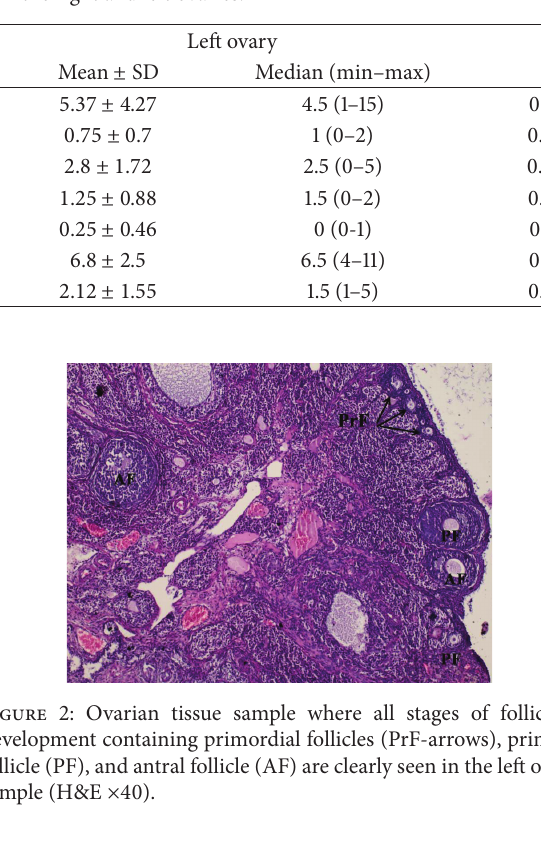
Table 1: Comparison of the follicles in the right and left ovaries.